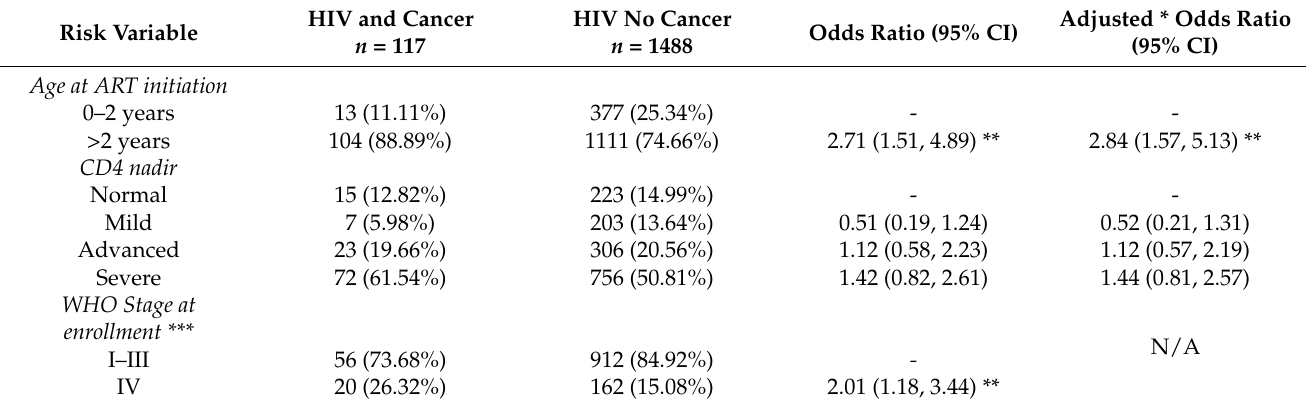
Table 3. Risk factors for cancer in children with HIV infection in the BIPAI